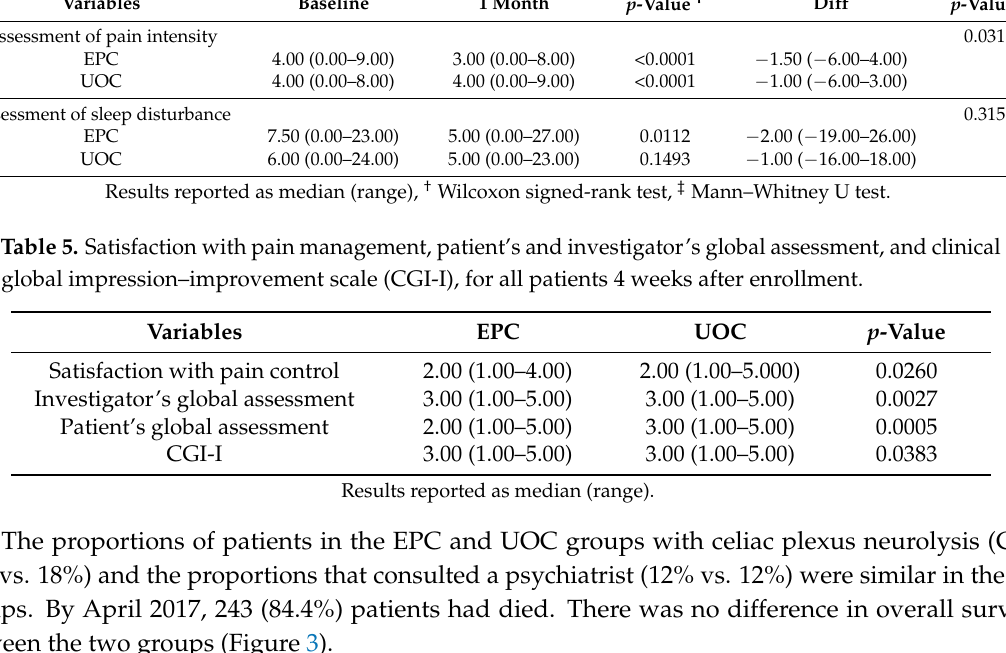
Table 4. Pain intensity and sleep disturbance, for all patients 4 weeks after enrollment. Variables Baseline 1 Month p -Value † Assessment of pain intensity